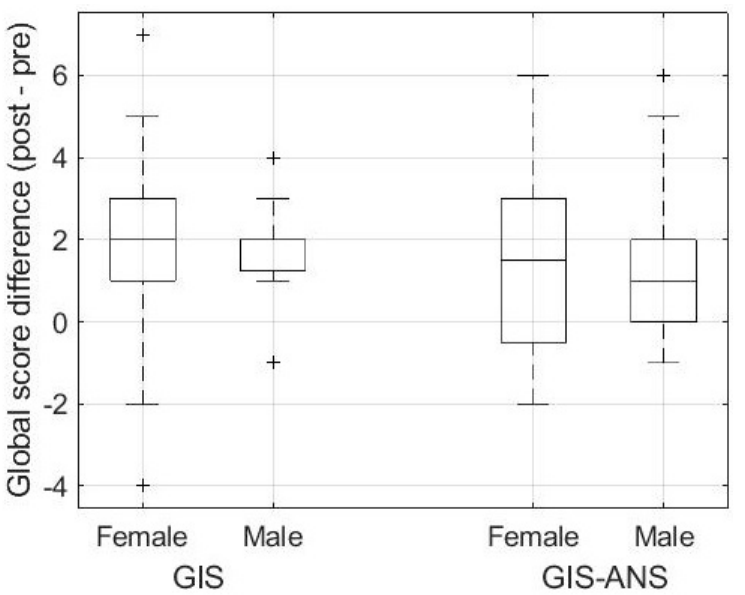
Figure 7. Improvement in the global STAT score from the pre- to the post-test (post-test–pre-test), by gender and curricular unit.